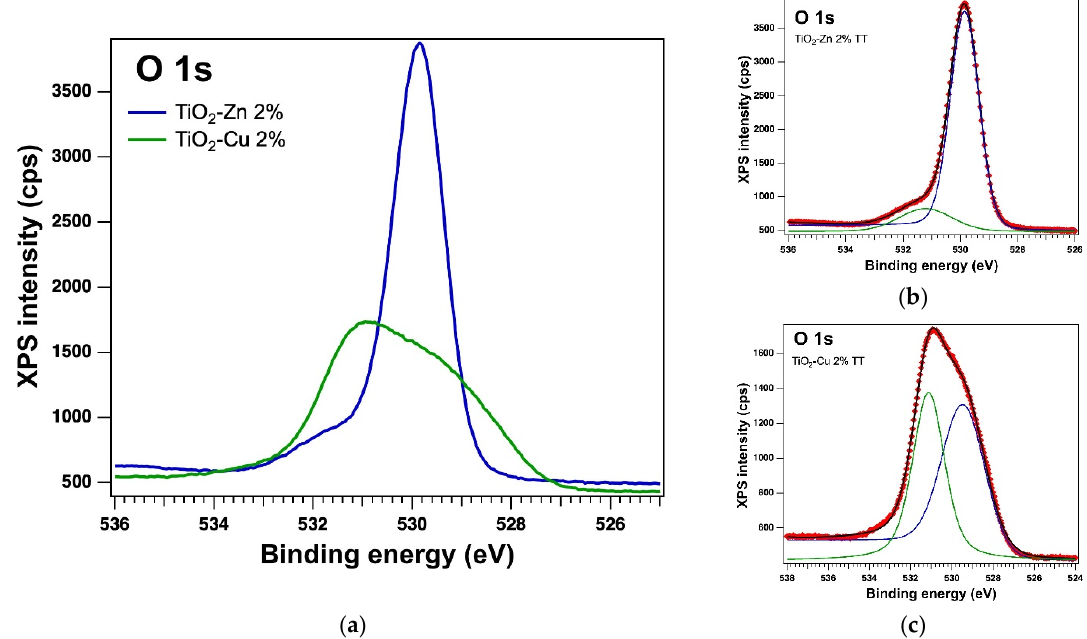
Figure 11. XPS spectra of the core level O 1s ( a ) overlayed XPS spectra of the thermally treated samples and the experimental data (red symbols) with the fit and deconvolutions for ( b ) the sample with Zn and ( c ) the sample with Cu; deconvolutions: components C1–blue line and C2–green line.